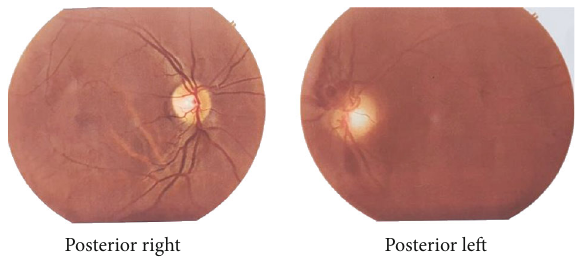
Figure 1: Fundus color